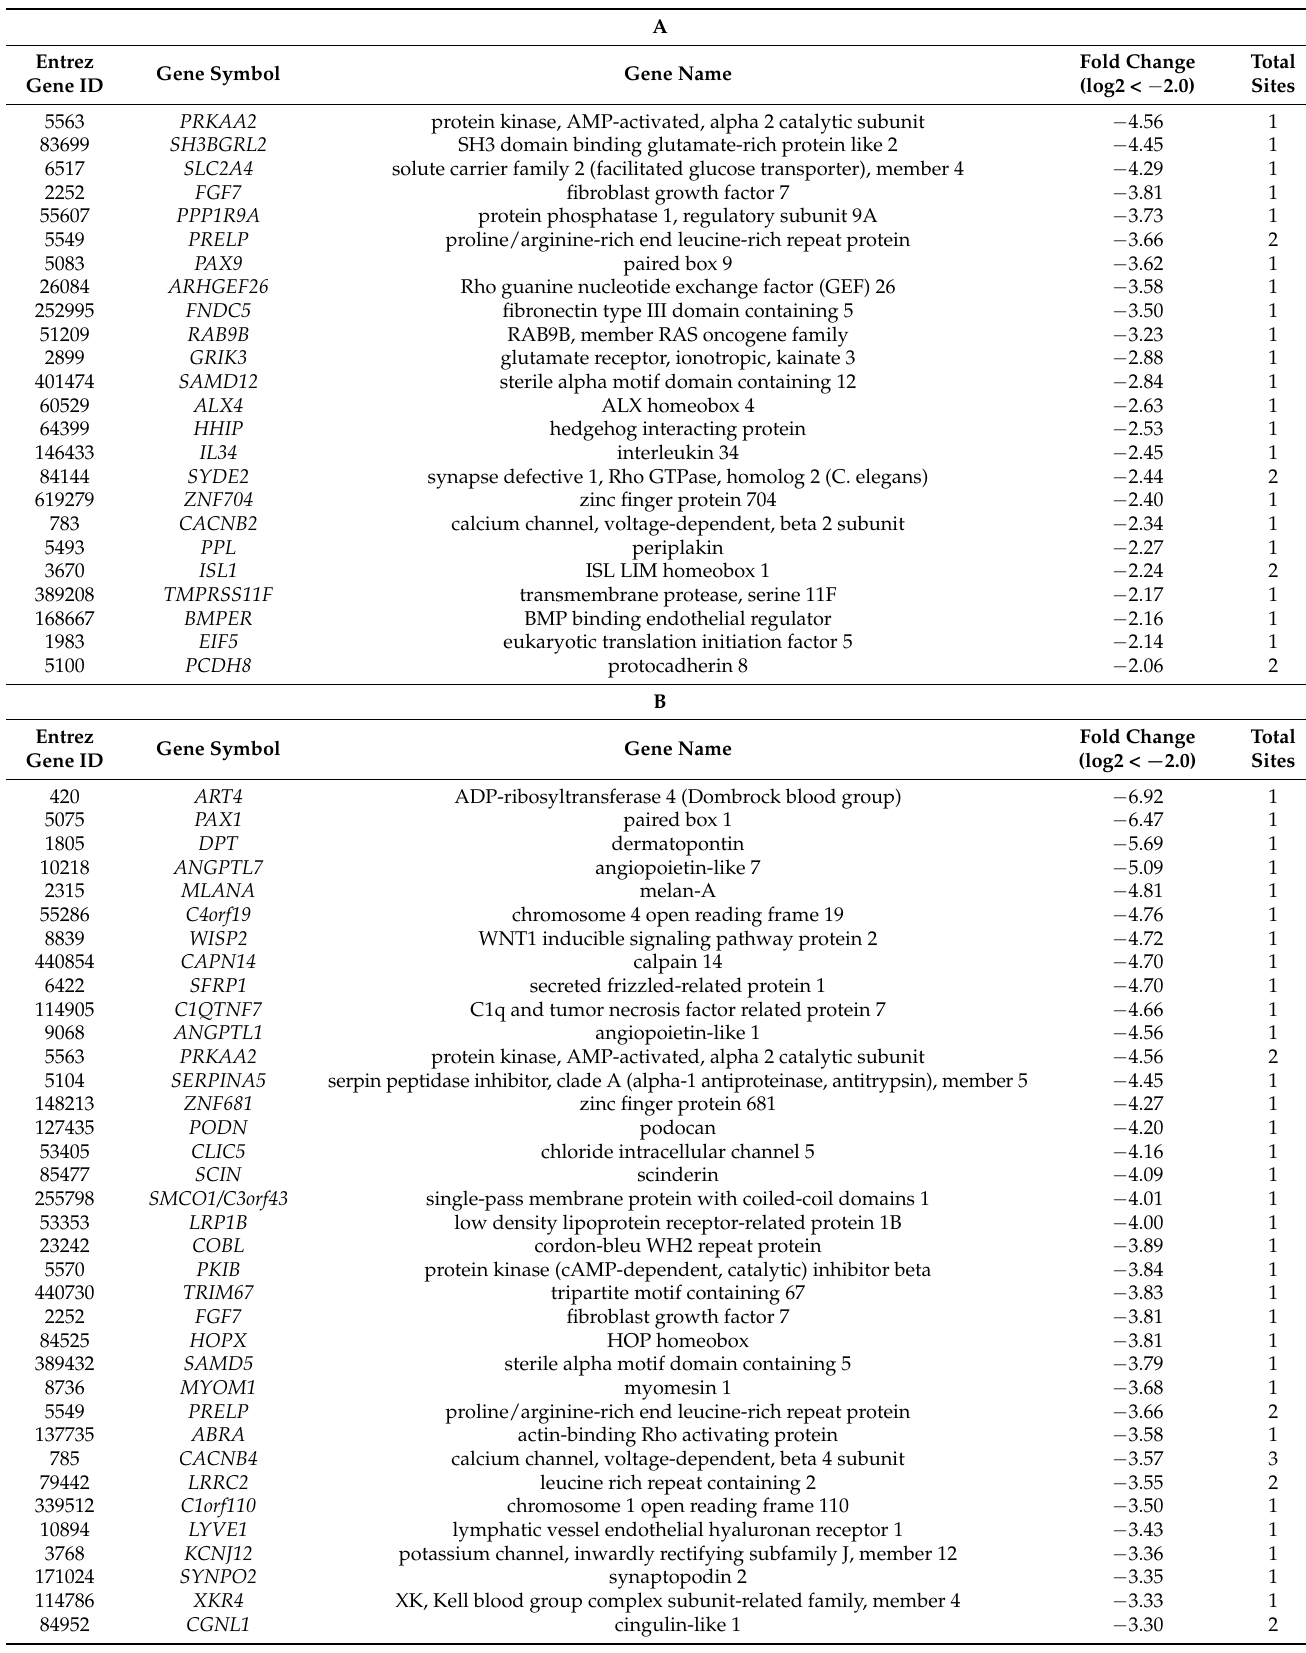
Table 1. A. Candidate target genes regulated by miR-31-5p . B. Candidate target genes regulated by miR-31-3p